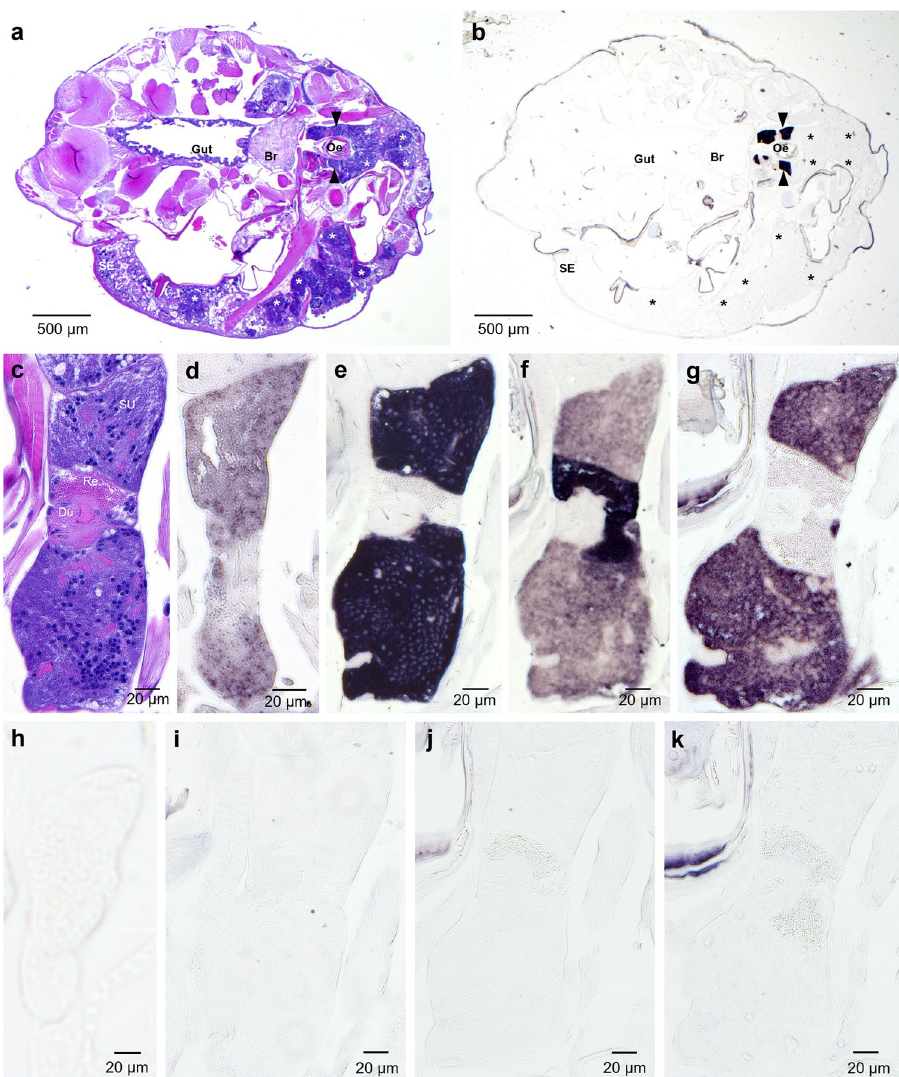
Figure 1. Localization of L. salmonis labial gland protein ( LsLGP ) genes by in situ analysis of a pre-adult II female salmon louse. Dark coloring indicates presence of transcripts. ( a ) Overview of the specimen (HE-staining) and ( b ) overview of the specimen hybridized with antisense LsLGP2 probe, where stars indicate tegmental type 1 glands and arrowheads indicate labial glands. Br Primitive brain, Oe Oesophagus, SE sub- epidermal tissue. A higher magnification of the labial glands treated with ( c ) HE, ( d ) antisense LsLGP1 probe, ( e ) antisense LsLGP2 probe, ( f ) antisense LsLGP3 probe ( g ) antisense LsLGP4 probe, ( h ) sense LsLGP1 probe, ( i ) sense LsLGP2 probe, ( j ) sense LsLGP3 probe, and ( k ) sense LsLGP4